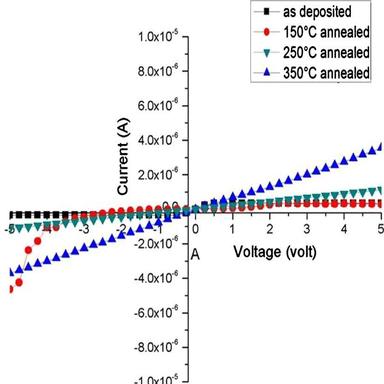
The current-voltage characteristics InBi2Se4 thin films.